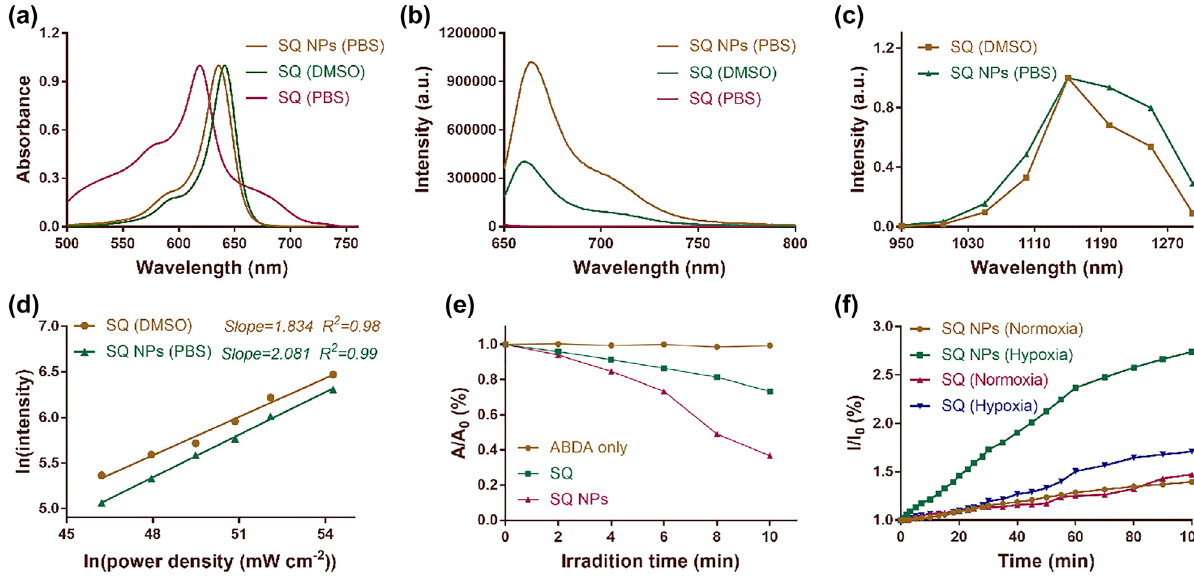
Figure 1: Photophysical properties of SQ dye. (a) Absorption spectra of SQ dye in DMSO and PBS, and SQ NPs in PBS. (b) Emission spectra of SQ dye in DMSO and PBS, and SQ NPs in PBS. Excitation: 635 nm. (c) Two-photon excitation spectra of SQ dye in DMSO and SQ NPs in PBS. (d) Laser-power-dependent luminescence of SQ dye and SQ NPs in PBS. Excitation: 1150 nm. (e) 1 O NPs in PBS. (f) ∙ OH generating capacity of SQ dye and SQ NPs in